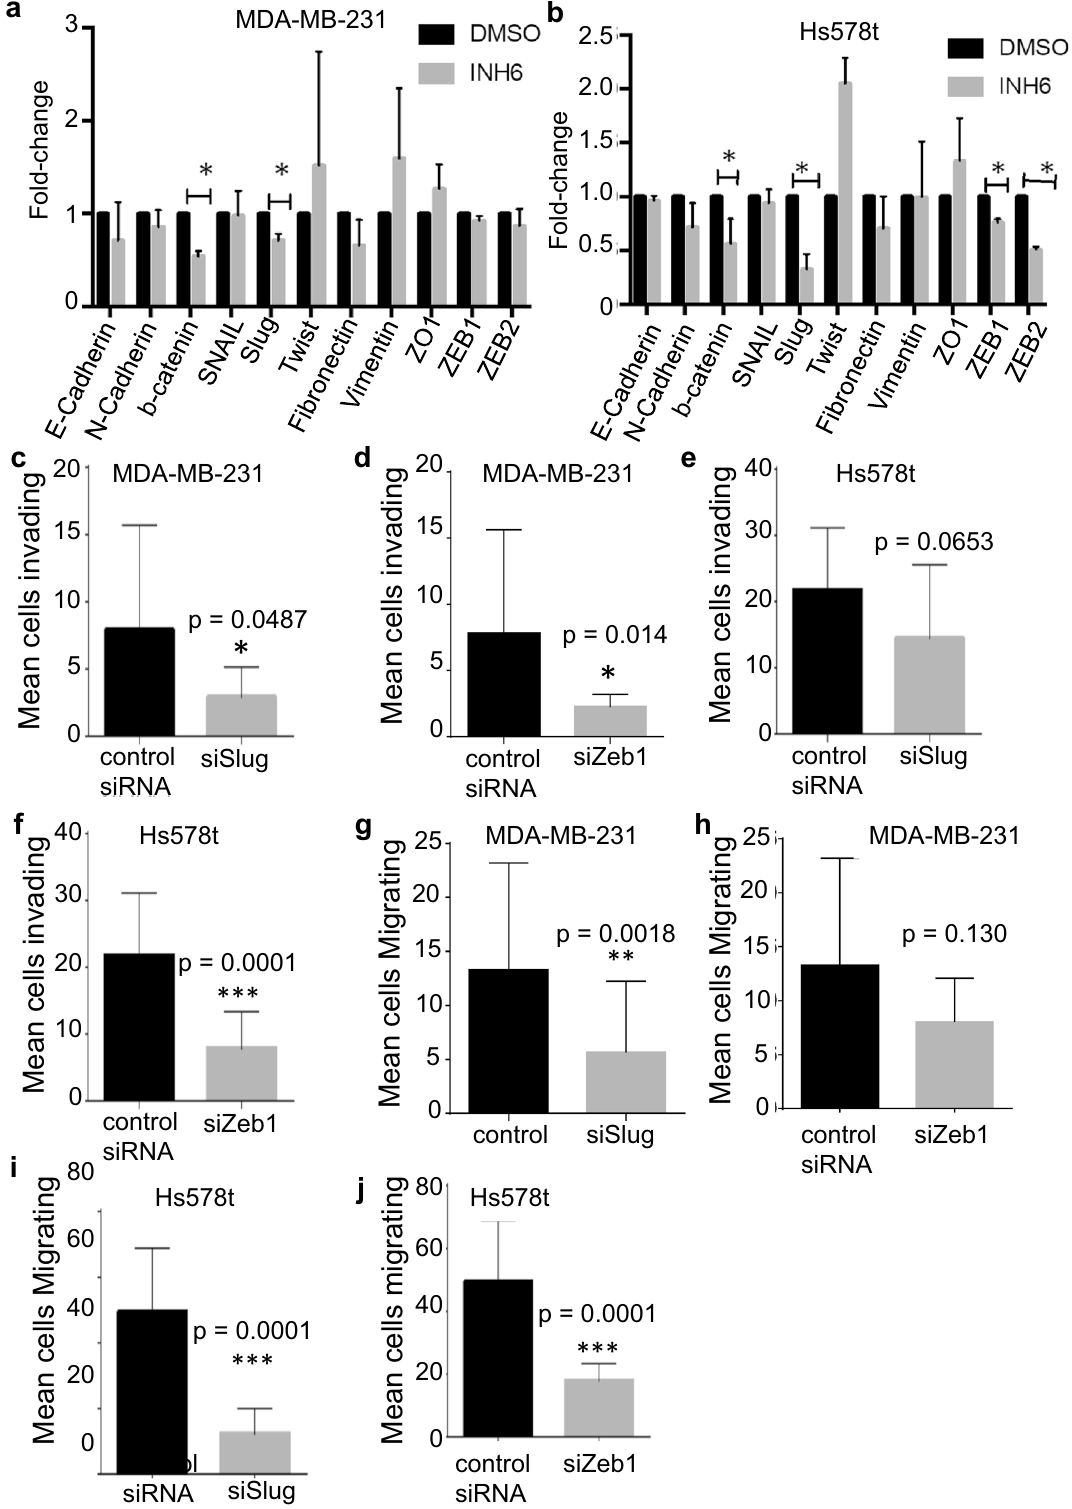
Figure 6. Nek2 induces mRNA level changes in EMT transcription factors. ( a,b ) qPCR analysis of EMT genes in MDA-231 and Hs578t cells. ( c–f ) Invasion of MDA-MB-231 or Hs578t treated with siSlug or siZeb1. ( g–j ) Migration of MDA-MB-231 or Hs578t treated with siSlug or